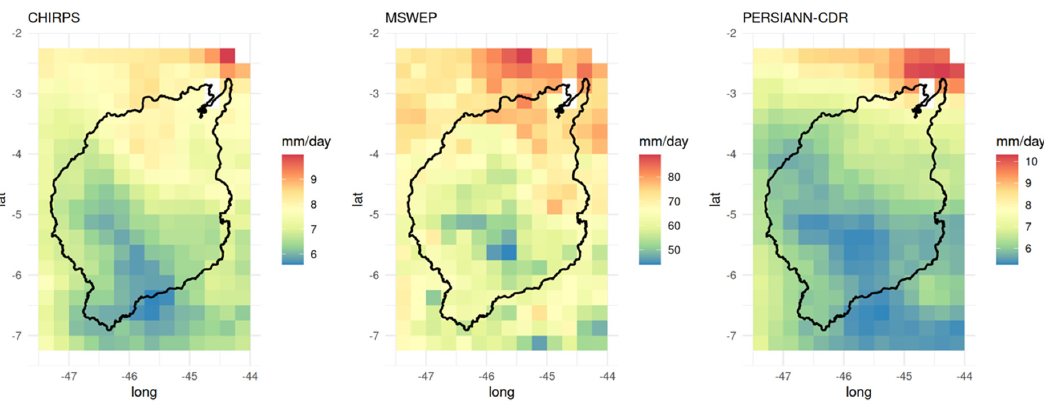
Figure 3. RMSE between gridBR and RES products for the total daily mean from 1983 to 2013. Each SRE has different representative scales.